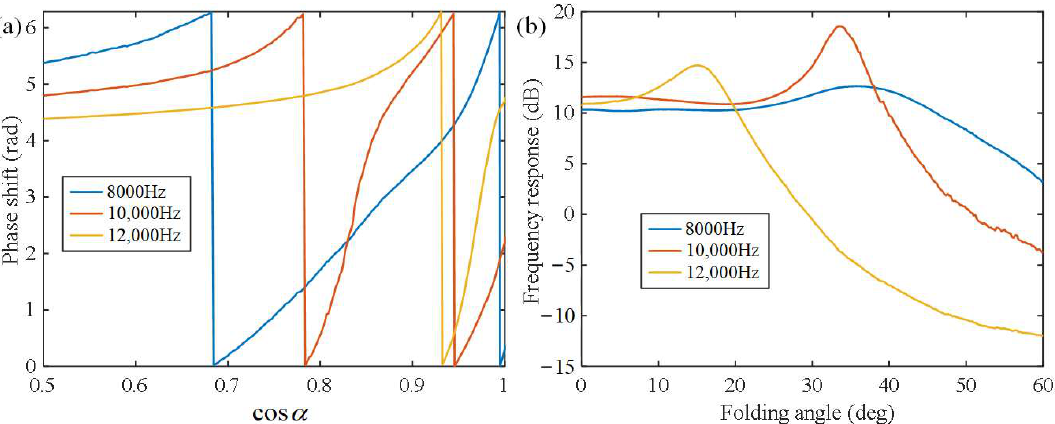
Figure 4. ( a ) The phase shift with respect to cos α at the three frequencies obtained from the numerical simulations. ( b ) Frequency response with respect to the folding angle at the three frequencies obtained from the numerical simulations.